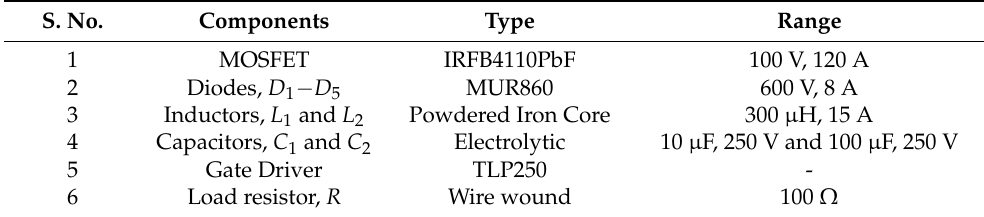
Table 2. Required Devices of the MQZS